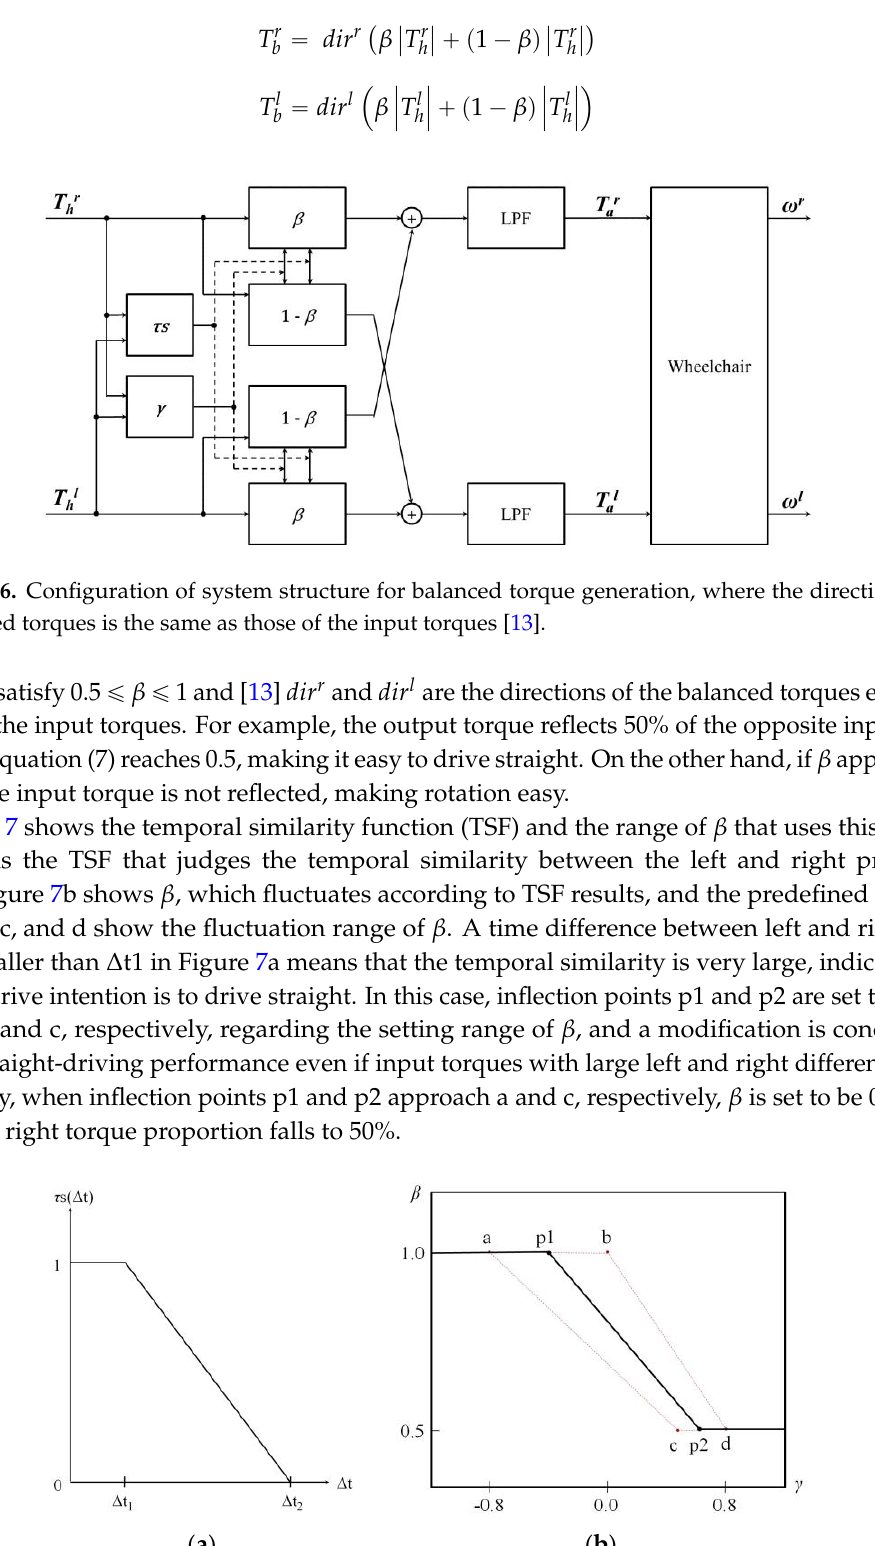
Figure 7. ( a ) The temporal similarity function and ( b ) the balance ratio design with its variation range [13]. a, b, c, and d are coordinates for the γ and β axes used in this study; these are (−0.8, 1.0), (0, 1.0), (0.5, 0.5), and (0.8, 0.5), respectively.